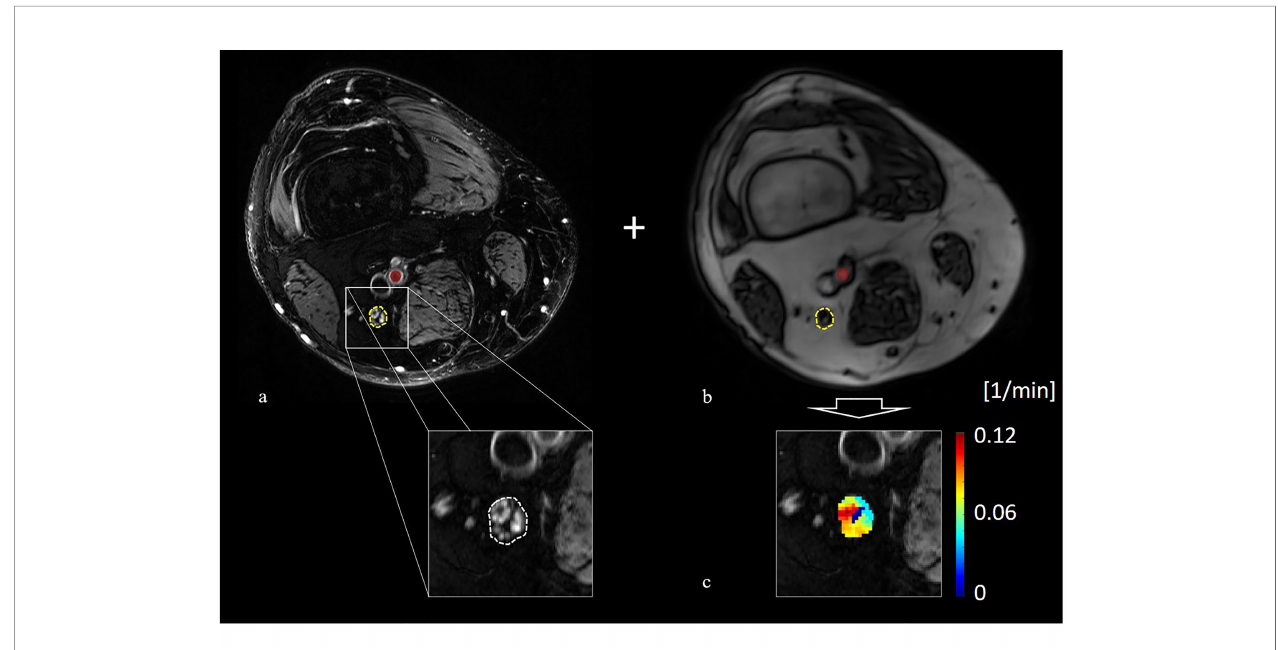
FIGURE 1 | Principle of image co-registration and assessment of nerve perfusion parameters: (A) T2-weighted image of the distal right thigh showing the tibial compartment of the sciatic nerve (yellow circle) and the position of the femoral artery (red circle), (B) axial T1-weighted volume interpolated breathhold examination sequence of the same position a s in (A) with the co-registered position of the sciatic nerve (yellow circle) and the femoral artery (red circle), (C) color coded map of K trans values obtained from the extended Tofts